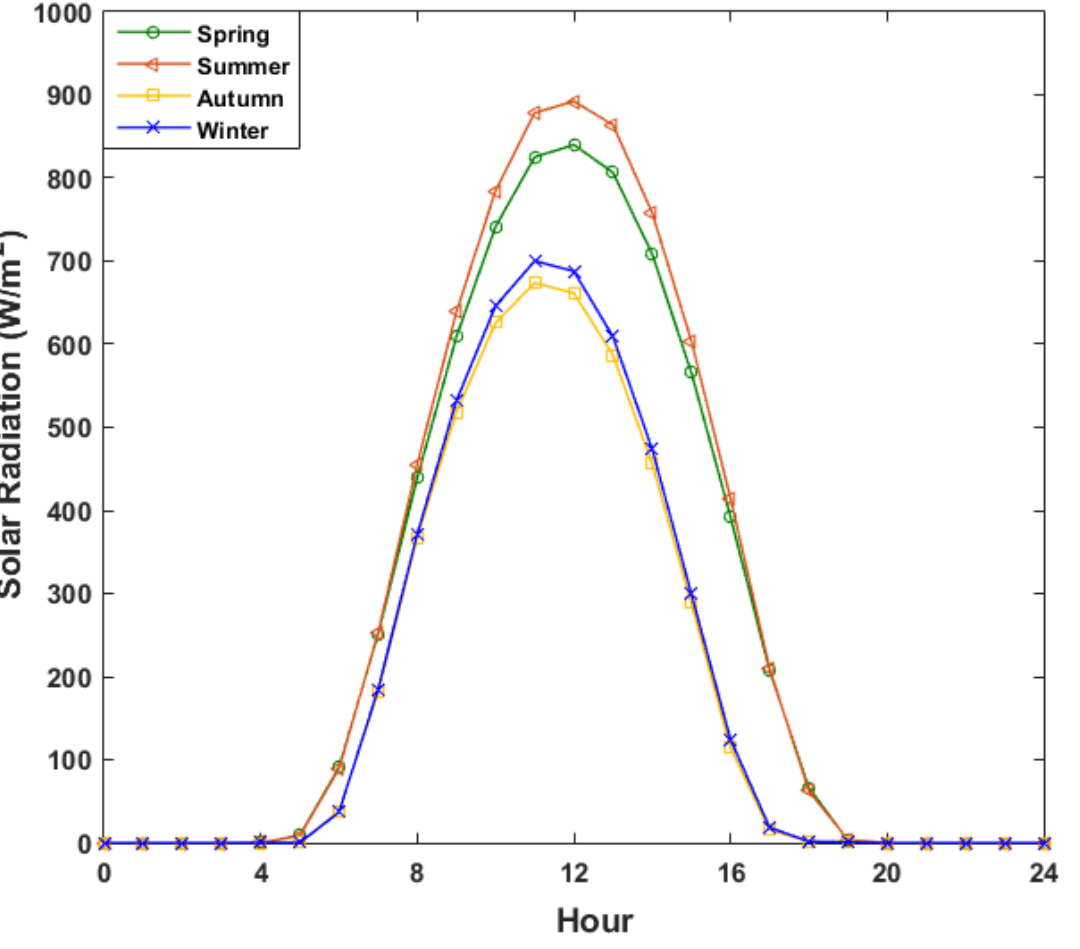
Figure 2. Solar irradiation data for Ilam (Iran).